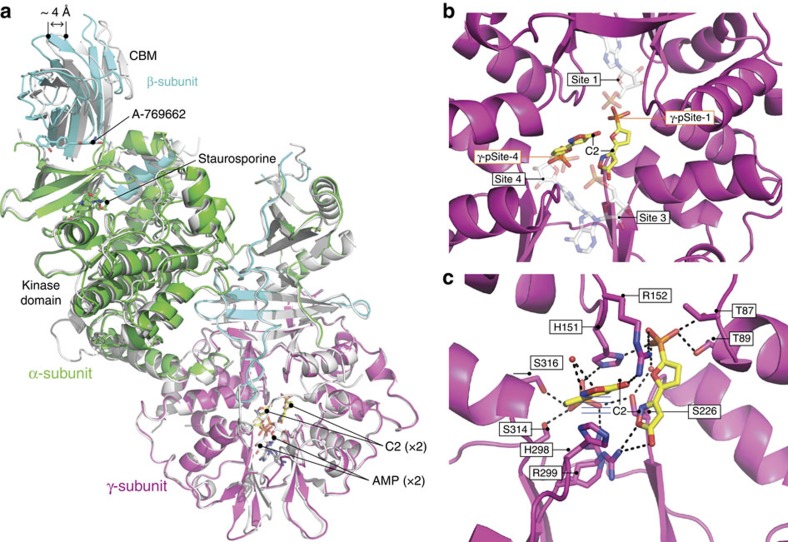
C2 binds the γ-subunit of AMPK.(a) Cartoon representation of the AMPK heterotrimer (α2β1γ1) bound to C2 (yellow sticks) in the γ-subunit (magenta), Staurosporine bound to the α-subunit (green) and A769662 bound at the ADaM binding site at the interface of the α-kinase domain and the CBM of the β-subunit (cyan) superimposed with the AMP-bound heterotrimer (white). Arrow shows the approximate distance between equivalent βCBM residues in the C2-bound and AMP-bound heterotrimers. (b) The position of C2 with respect to CBS sites, with AMP superimposed (from PDB 4CFE). (c) AMPK interactions (black dashed lines and blue parallel lines for π stacking) with C2 (yellow sticks). Key residues (labelled) are modelled as sticks. Note that γ-Arg299 was modeled in two discrete conformations.